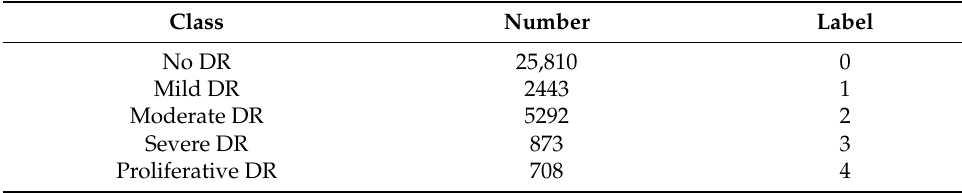
Table 2. Description of Kaggle